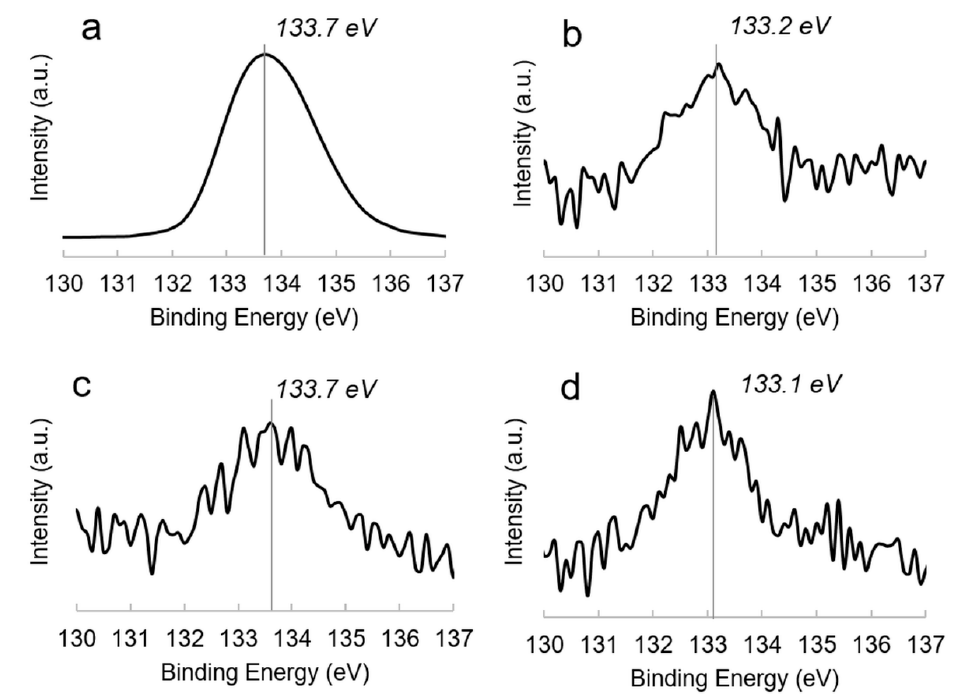
Figure 5. P2p high-resolution spectra of CD ( a ), PCL/HA ( b ), PCL/CD ( c ) and PCL/HA-CD ( d ) samples.